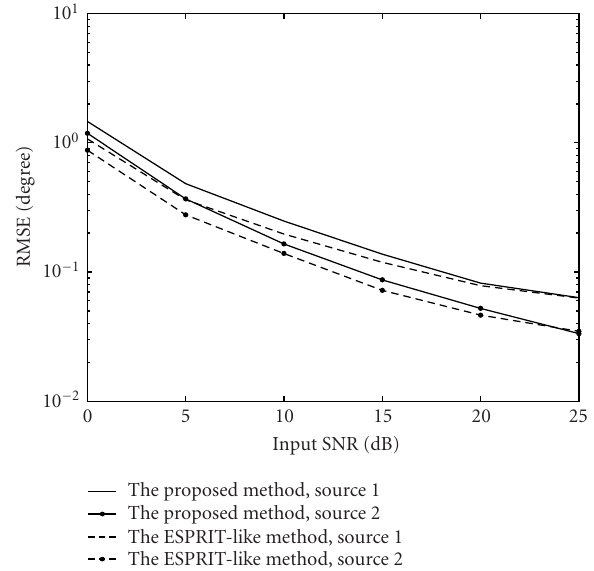
Figure 2: The RMSE of the estimated DOA over 500 Monte Carlo runs versus the input SNR; 14 sensors and 1000 snapshots are used and the two equi-power sources approach the array from 38 ◦ and 20 ◦ ,